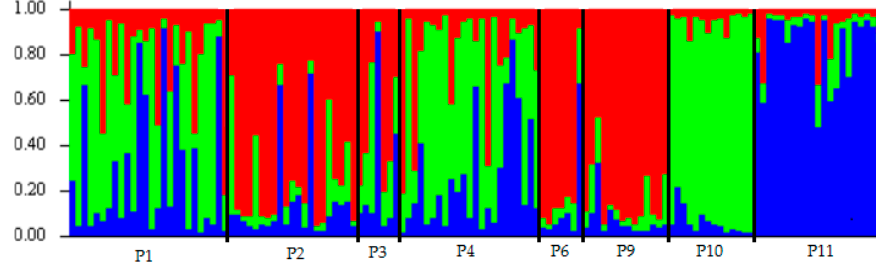
Figure 2. Relations between the rational groups number K and estimated value Δ K.